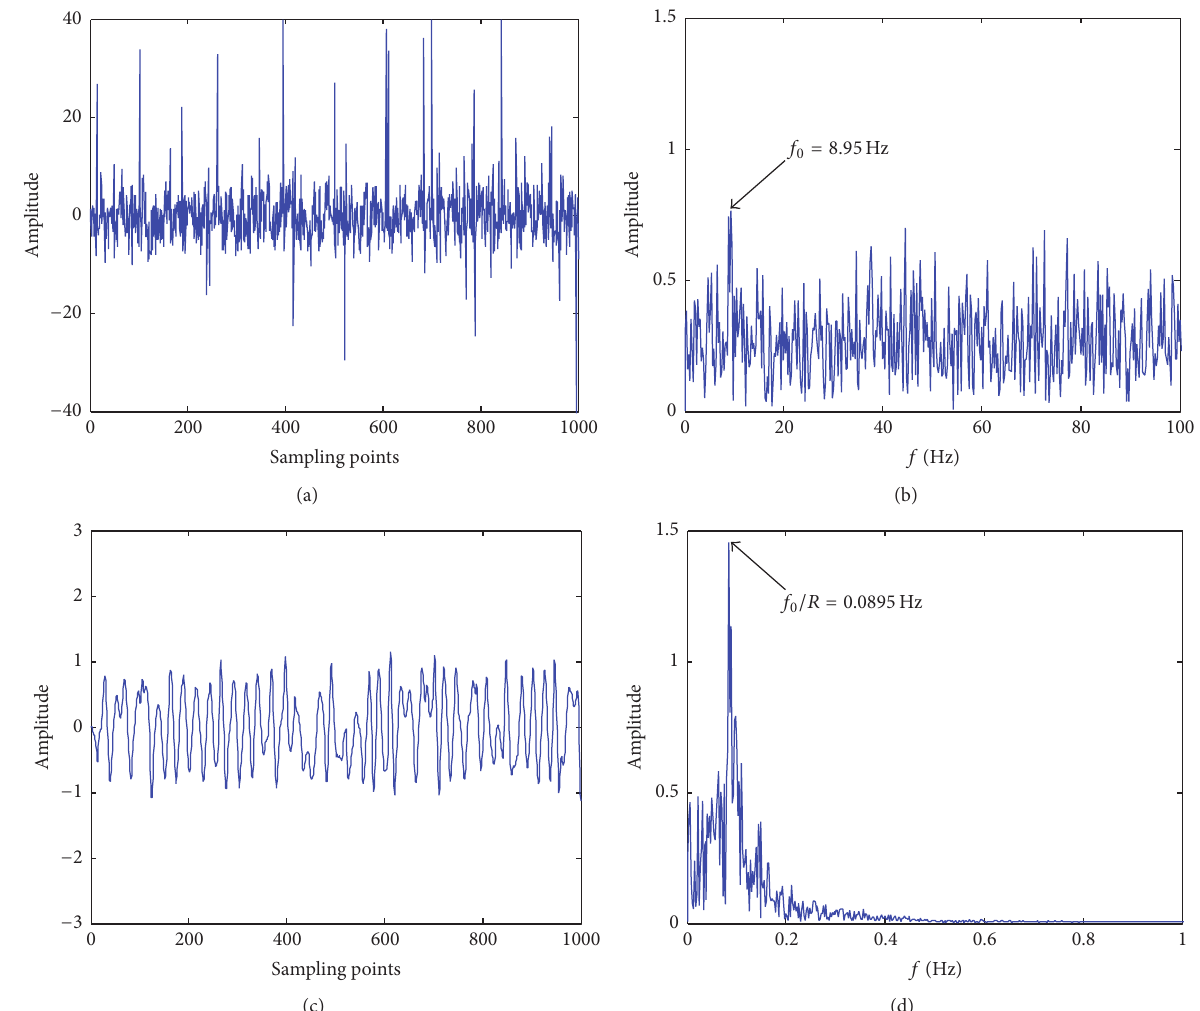
Figure 15: Fault diagnosis result with the proposed method in mild wear of floating tile. (a) Time-domain waveform of selected signals, (b) frequency spectrum of selected signals, (c) time-domain waveform of output signals, and (d) frequency spectrum of output signals. The system parameters are set to 𝜀 = 1/10 , 𝑅 = 100 , 𝑎 = 0.3 , 𝑏 = 2.2 , and 𝑘 = 0.22